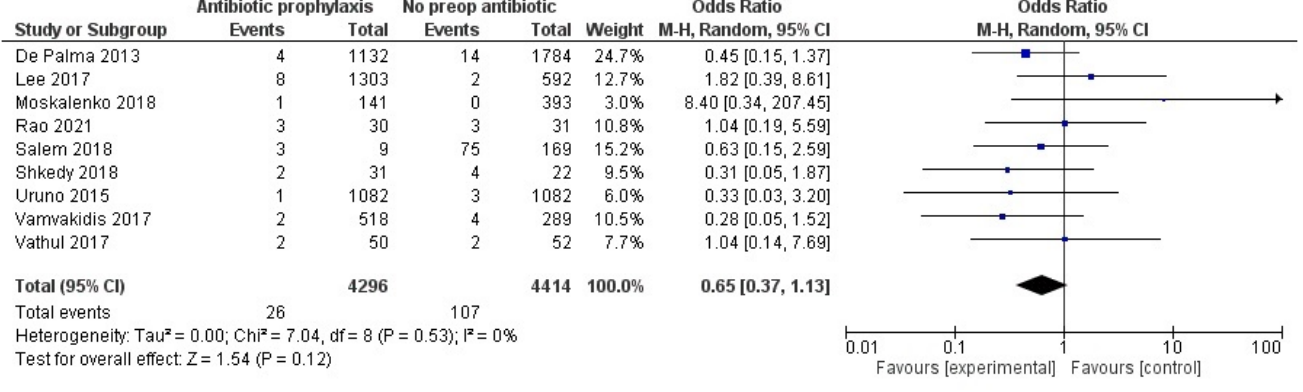
Figure 3. Forest plot for SSI rate in AP group vs. control group (no AP)—All studies. In order to avoid spurious results due to weak statistical power, the funnel plot and Egger’s regression test were not used due to the small number of retrieved studies (below 10) [30].